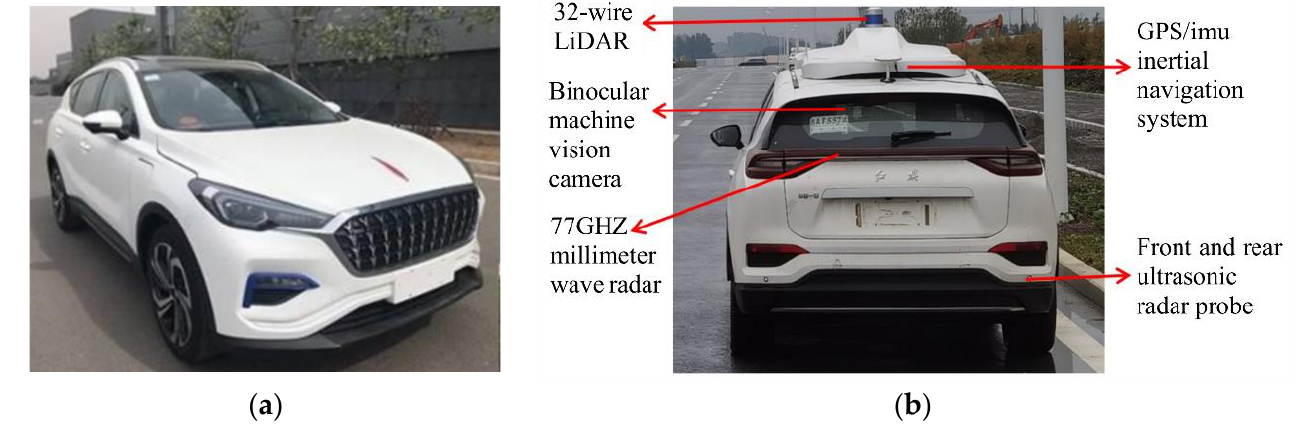
Figure 10. Experimental vehicle configuration: ( a ) experimental vehicle; ( b ) sensor locations. Table 5. Hardware equipment of real vehicle test platform.